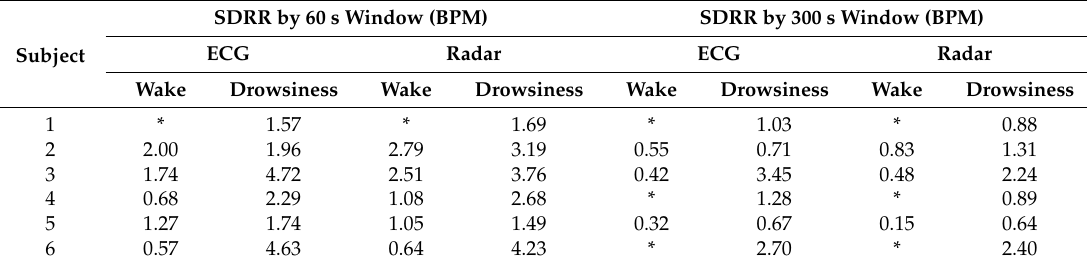
Table 4. The average of SDRR in the wake–drowsiness states obtained from the analysis window.